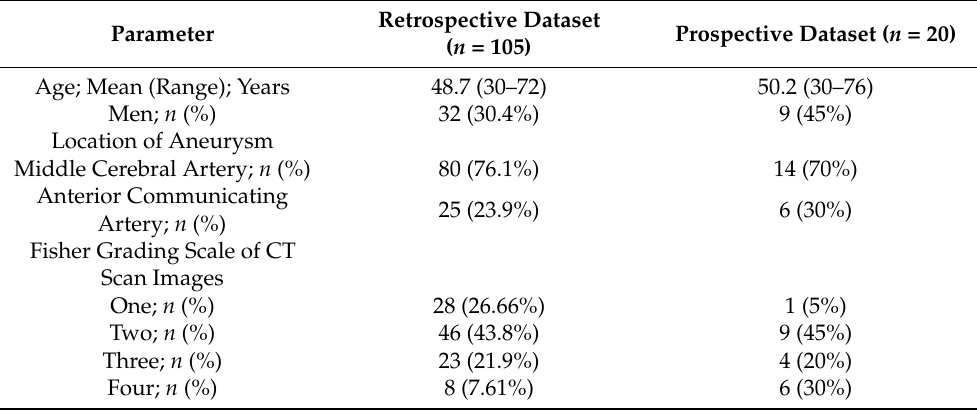
Table 1. Demographic and surgical characteristics of the patients in retrospective and prospec- tive datasets.